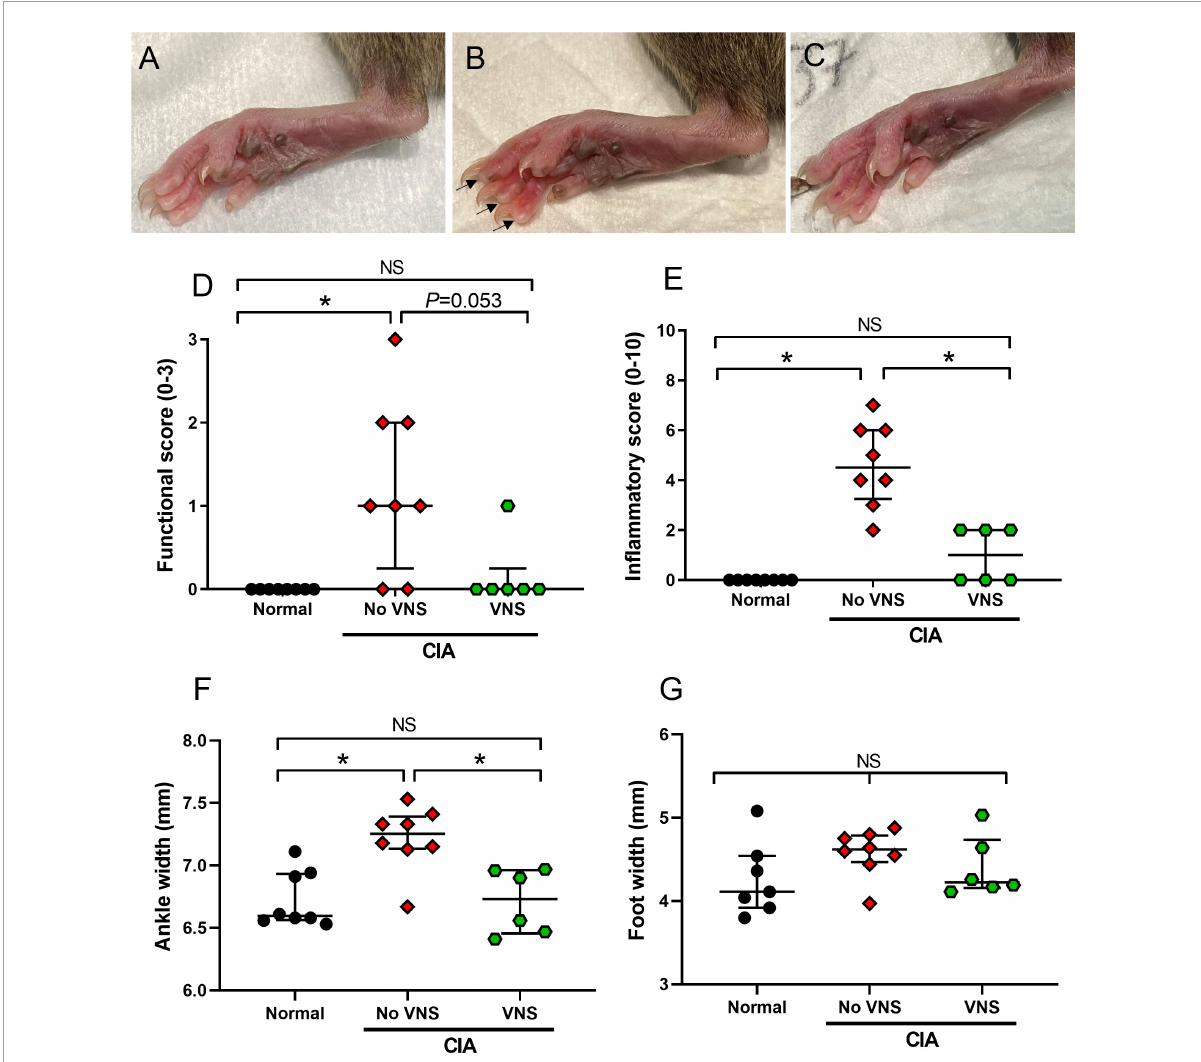
FIGURE2 Effects of vagus nerve stimulation improves on measures of disease activity index at 17 days following collagen injection. (A–C) Representative images of hind paws from normal (A) , unstimulated collagen-induced arthritis (CIA) [ (B) , no vagus nerve stimulation (VNS), inflamed digits indicated by arrows], and stimulated CIA [ (C) , VNS] rats at 17 days following a collagen injection. (D) Limping was assessed by measuring functional score. (E) Inflammation of the paws was assessed by measuring inflammatory score. (F,G) Swelling of hind paws was assessed by measuring ankle width (F) and foot width (G) . Data show median ± interquartile range and symbols are values from individual rats. Differences between normal ( n = 7–8), no VNS ( n = 8), and VNS ( n = 6) groups was analyzed using Kruskal–Wallis one-way ANOVA and Dunn’s post-hoc test. Significant differences of P < 0.05 are indicated by “*” and non-significant differences as